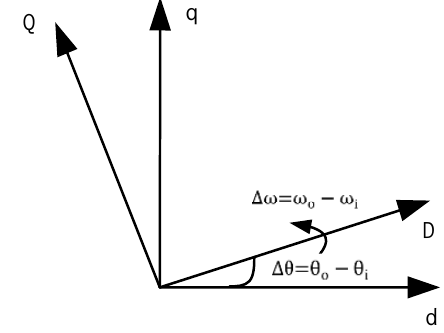
Figure 5. dq axis coordinate system of the electromagnetic coupler.